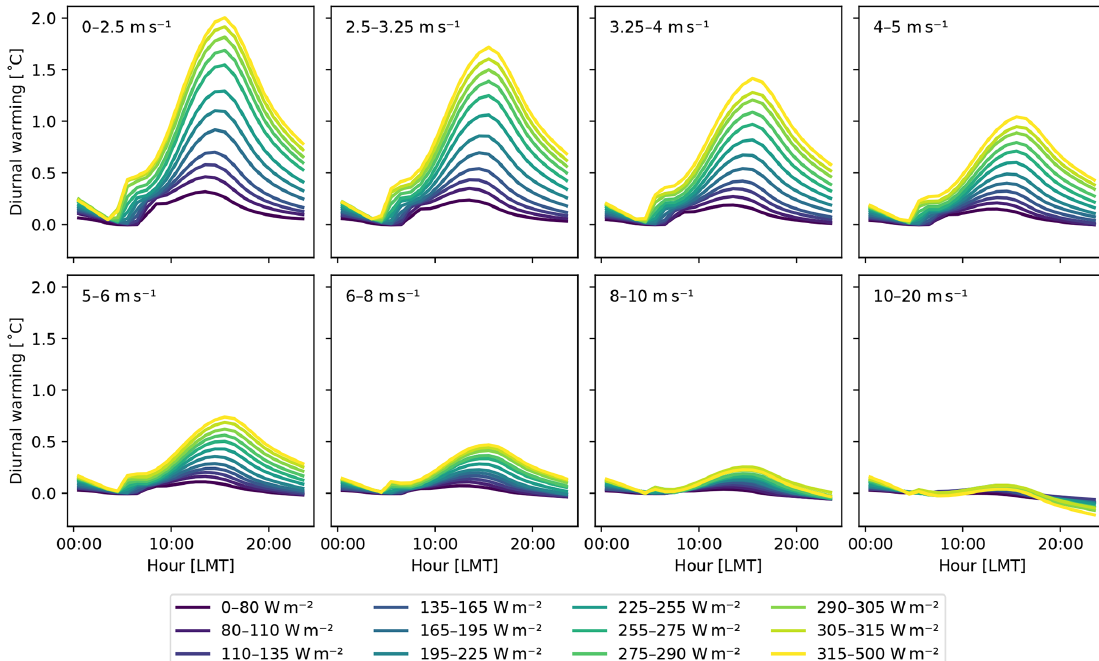
Figure 1. The magnitude of the diurnal warming at the subskin level as a function of the time of the day for different wind and insolation categories. The diurnal warming is measured with respect to the SST at local sunrise. The wind categories are represented by the different panels, while the insolation categories are shown as different curves within each panel.